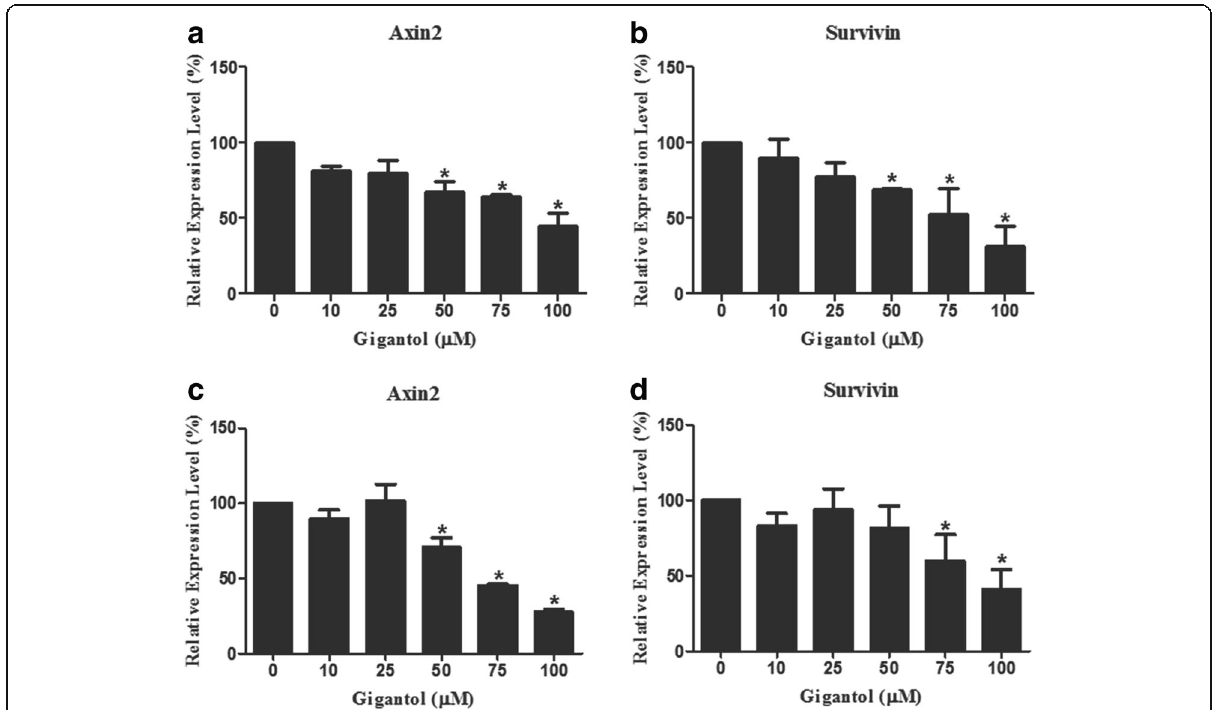
Fig. 5 Gigantol reduces the mRNA levels of Wnt target genes in breast cancer cells. a-d MDA-MB-231 ( a and b ) and MDA-MB-468 ( c and d ) cells were treated with the specified amounts of gigantol for 24 h. RNA was extracted and then reverse-transcribed into cDNA. Prepared cDNA was then subjected to real-time PCR analysis to detect the mRNA expression of Axin2 ( a and c ) and Survivin ( b and d ). Gigantol treatment significantly reduced the mRNA level of Axin2 and Survivin compared with DMSO treated control cells, * p < 0.05